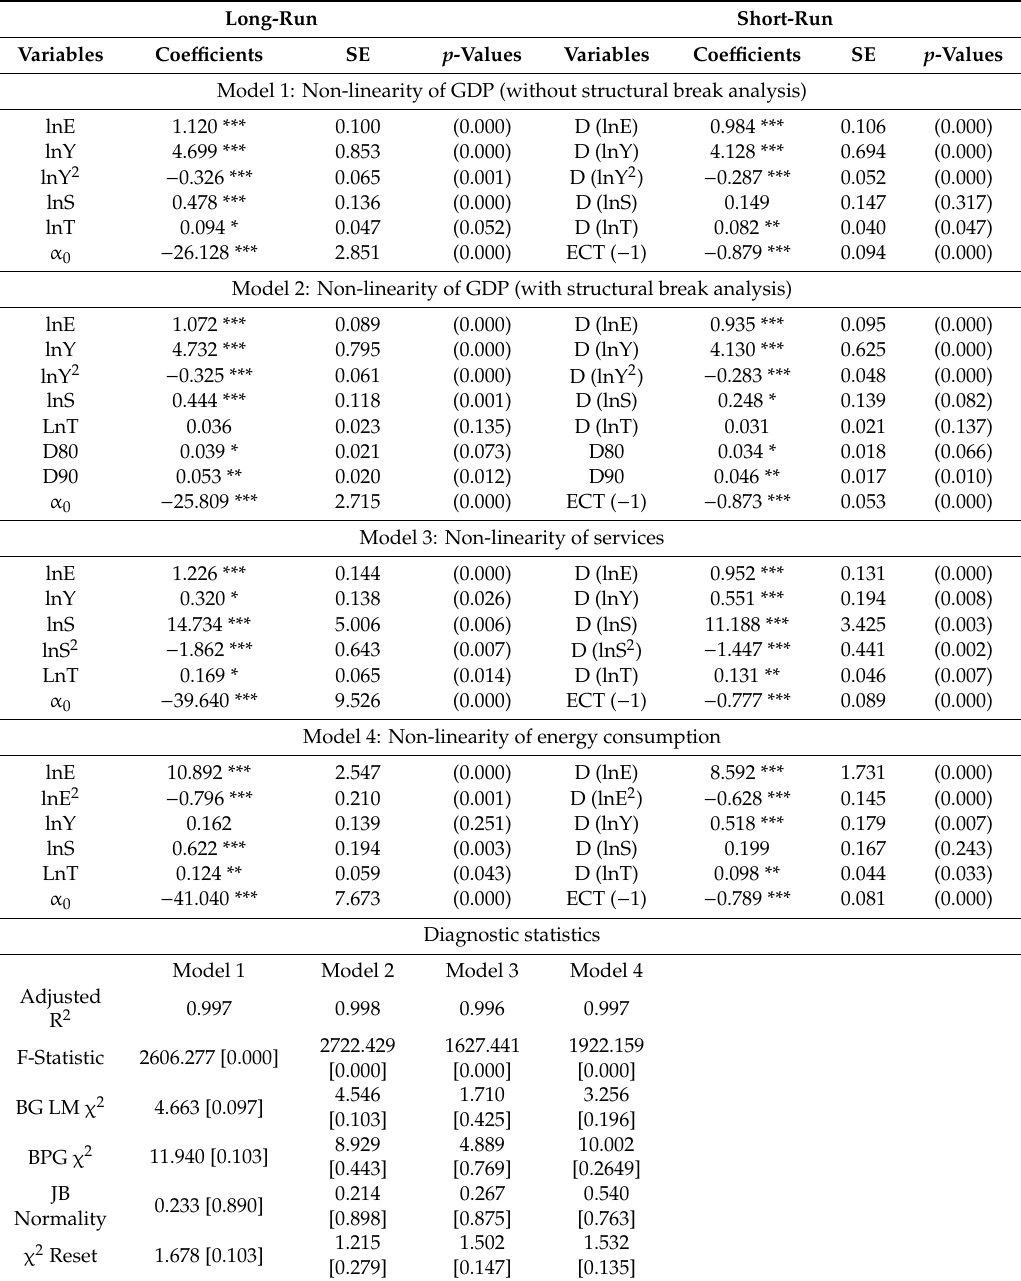
Table 7. Short-term and long-term results of ARDL